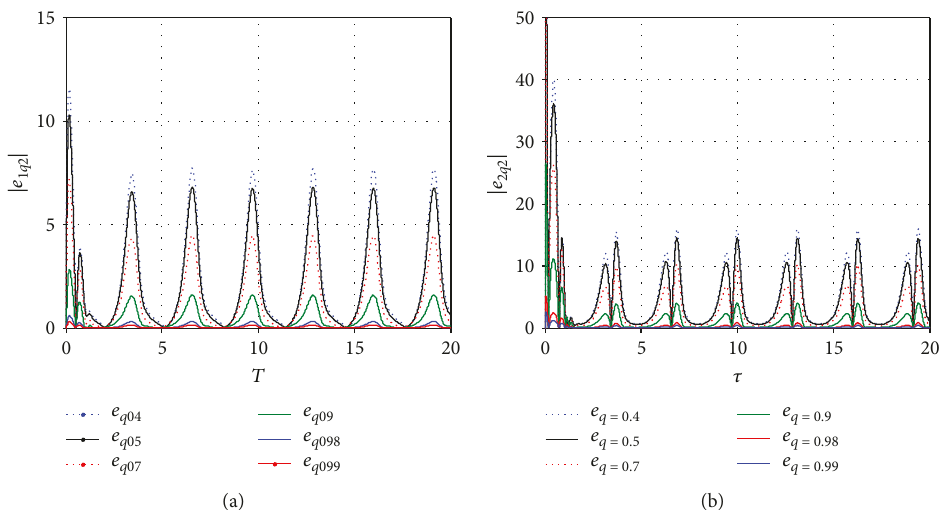
= 0 4 , q = 0 5 , q = 0 7 , q = 0 9 , q = 0 98 , and 2 2 2 2 2 = u − u u 2 q 2 1 q 2 .